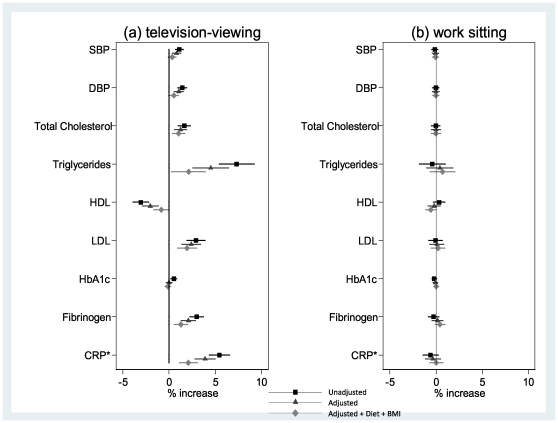
Mean % change (95% CI) in biomarker level, for women, per category increase in television-viewing (a) and sitting at work (b).Footnote: SBP = systolic blood pressure; DBP = diastolic blood pressure; HDL = high-density lipoprotein; LDL = low-density lipoprotein; HbA1c = glycated haemoglobin; CRP = C-reactive protein. *Quarter % change in CRP level per category increase in sedentary behaviour. Corresponding values for a % change in CRP per category increase in (a) television-viewing: 21.72% (95% CI: 17.42%, 26.02%), 15.56% (11.21%, 19.90%) and 8.39% (4.49%, 12.28%) and (b) sitting at work: −2.33% (−5.54%, 0.88%), −1.33% (−4.58%, 1.92%) and 0.13 (−2.74%, 3.00%) for “unadjusted”, “adjusted” and “adjusted+BMI+Diet” respectively. N varies from 3,752 to 3,037 due to variation in missing data. Model “Adjusted” includes: moderate-vigorous leisure activity frequency, smoking, social class at birth and in adulthood, education level, birth-weight, longstanding illness limiting daily activity, menopausal status, HRT and OC use; for total, HDL and LDL-cholesterol, triglycerides, HbA1c, fibrinogen and CRP additional adjustment for hypertension; for SBP, DBP, HbA1c,fibrinogen and CRP additional adjustment for total and HDL-cholesterol. Model “Adjusted+Diet+BMI” includes: all factors mentioned above plus consumption of chips, sweets/chocolates, alcohol, and BMI.